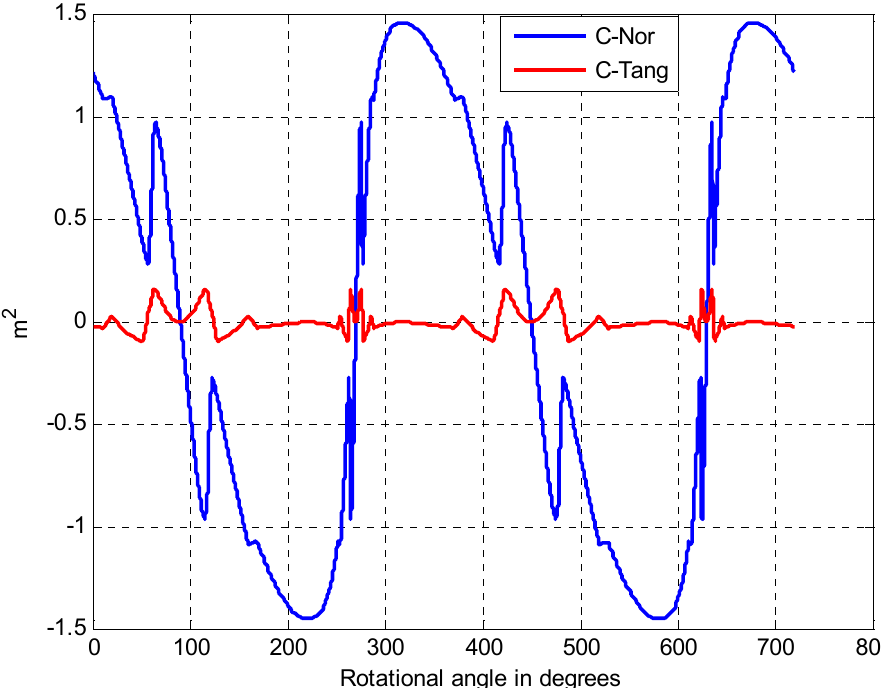
Figure 19. Normal and tangential coefficient variations as functions of rotational